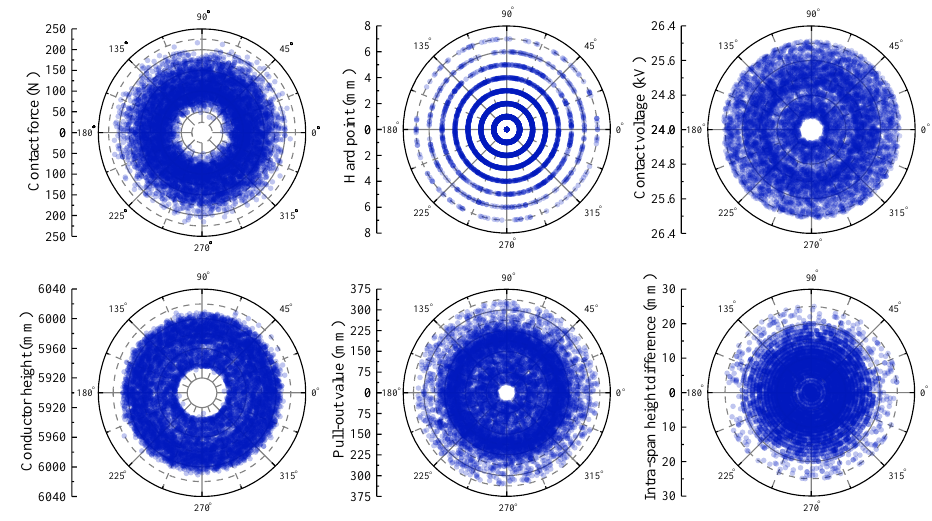
Figure 4. Some historical detection data of a catenary. The data were gathered by the railway power supply security detection and monitoring system, combined with the manual troubleshooting records, and cleaned. The data set contained one label, RUL, with a range of 0 to 172 days, and six attributes, including pull-out value, conductor height, contact force, hard point, contact voltage and intra-span height difference. The following is the attribute information: